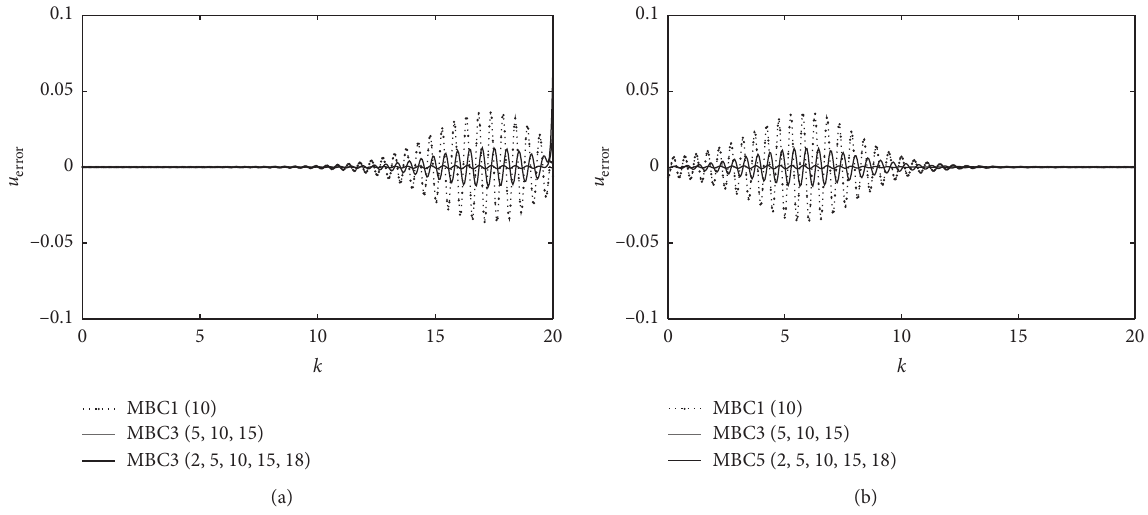
Figure 8: Error of displacement with the major wave number k � 12: (a) t � 1.0; (b) t �